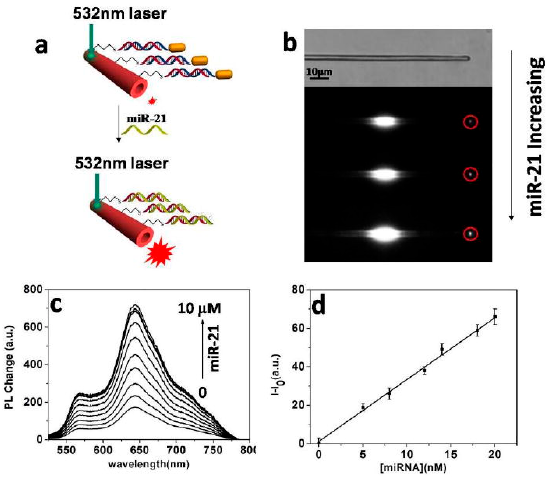
Figure 15. Detection of miRNA-21 based on Au@PDA microtube waveguide. ( a ) Schematic diagram. ( b ) Microscopy of PDA microtube and Au@PDA microtube waveguide sensor with increasing miR-21. ( c ) PL changes for tip emission of PDA microtube upon increasing miRNA-21. ( d ) Plot of PL changes of the waveguided tip emission at 640 nm upon addition of miR-21. I 0 and I represent PL intensity before and after reaction with miRNA-21, respectively (the whole Figure 15 was reprinted with permission from Zhu et al. [64]).